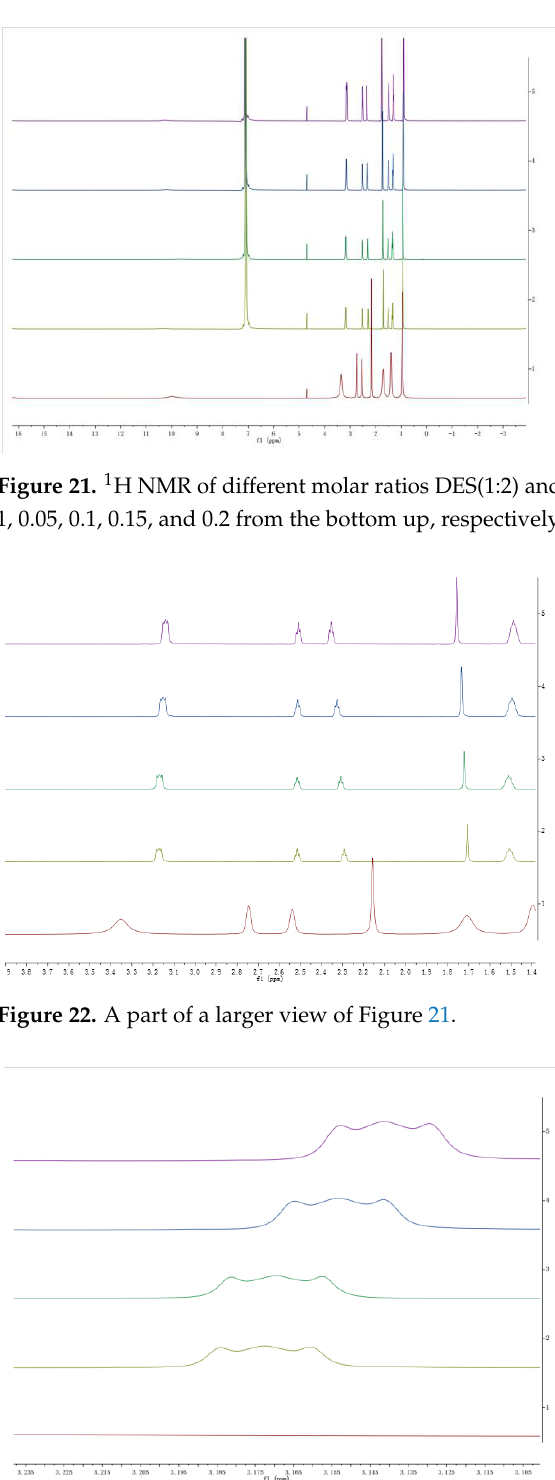
Figure 20. 1 H NMR of TBAB, LA and benzene estimated by ChemDraw.